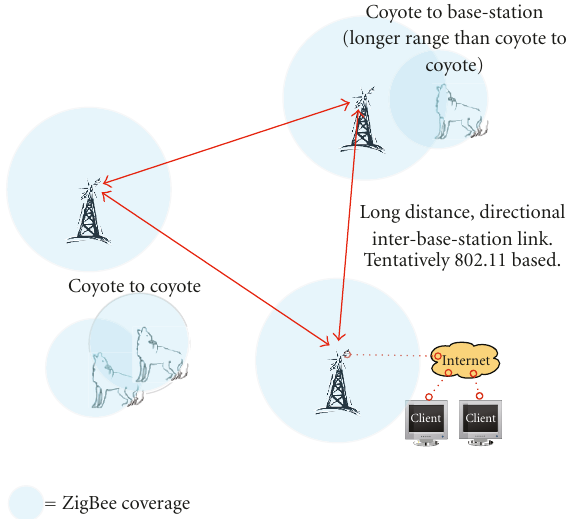
Figure 1: Overview of the CARNIVORE network. A predator, such as a coyote, wears a collar containing a CSN while fixed base stations or SRNs act as data sinks. CSN-to-SRN wireless range is greater than coyote-to-coyote wireless range because the base stations employ high-gain collinear antennas. An SRN has been developed for capturing data from CSNs; however, the final SRN has yet to be implemented to deliver data via the